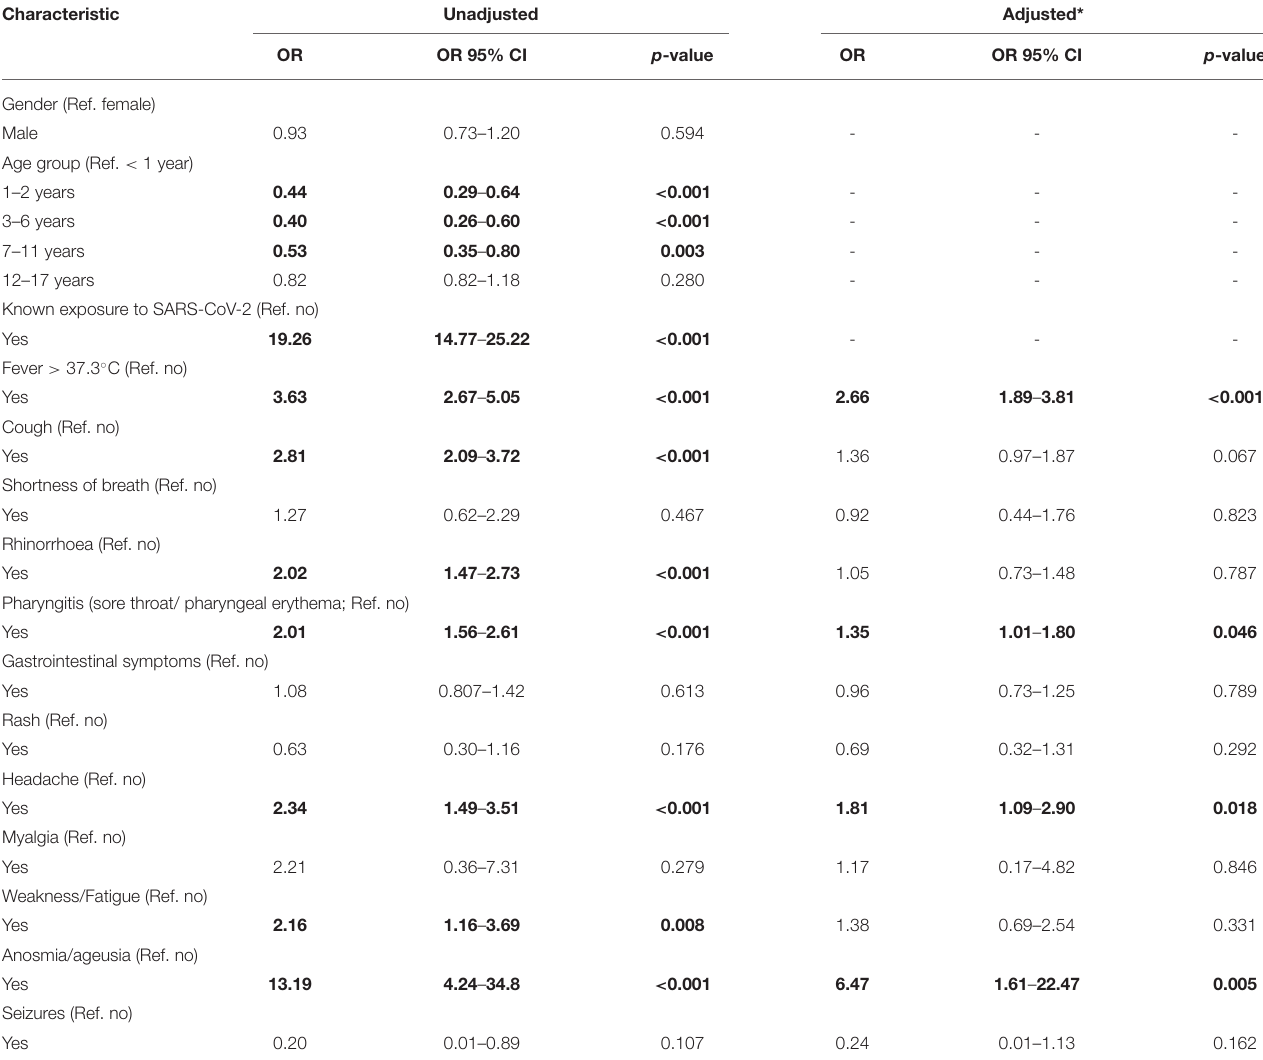
TABLE 2 | Predictors of positive SARS-CoV-2 test results. Characteristic Unadjusted Adjusted* OR OR 95% CI p -value OR OR 95% CI p